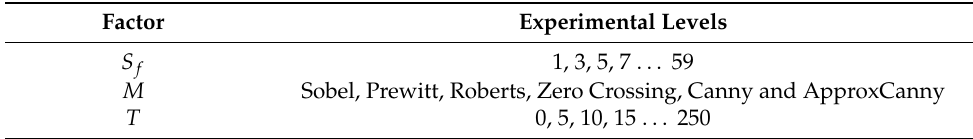
Table 2. Test factors and their correspondent experimental levels.